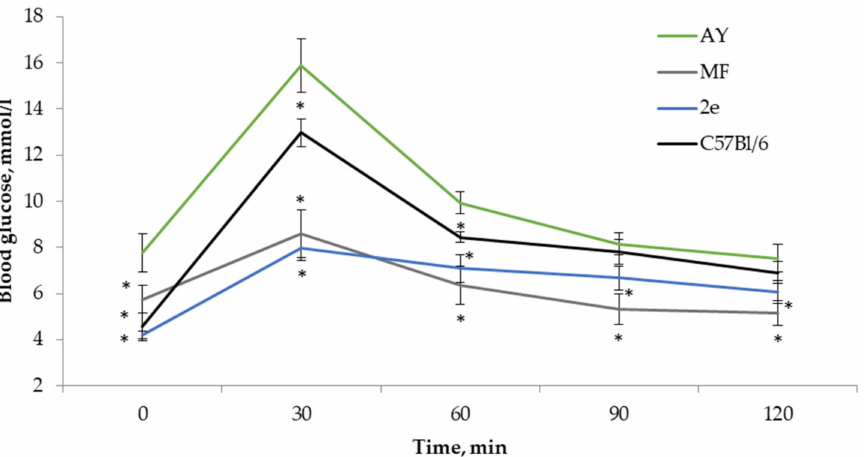
Figure 3. OGTT results. The test conducted after 14 days of AY mice treatment by compound 2e. Doses: 2e —15 mg/kg, MF—250 mg/kg. * p < 0.05 as compared to AY